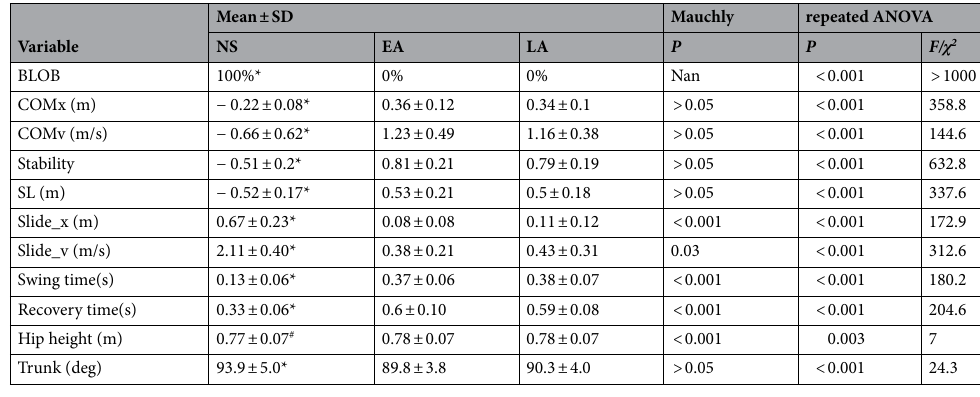
Table 1. Repeated ANOVA results of all the gait variables during slipping ( F value) and Kruskal–Wallis test for BLOB rate ( χ 2 ). Positive stability indicate stable COM state, and negative value indicate unstable COM state. Trunk angle > 90 indicates trunk extension, and the angle < 90 indicates trunk flexion. Recovery time is the duration between RTD and LTD2, COMx, COMv, and stability was calculated at pre-LTD2. Slide_x denotes slip distance, slide_v denotes slip velocity, NS denotes novel slip, EA denotes early-adaptation, and LA denotes late-adaptation. *Significant difference between NS and EA, and between NS and LA (p < 0.001 for all). # Significant difference between NS and EA, and between NS and LA (p ≤